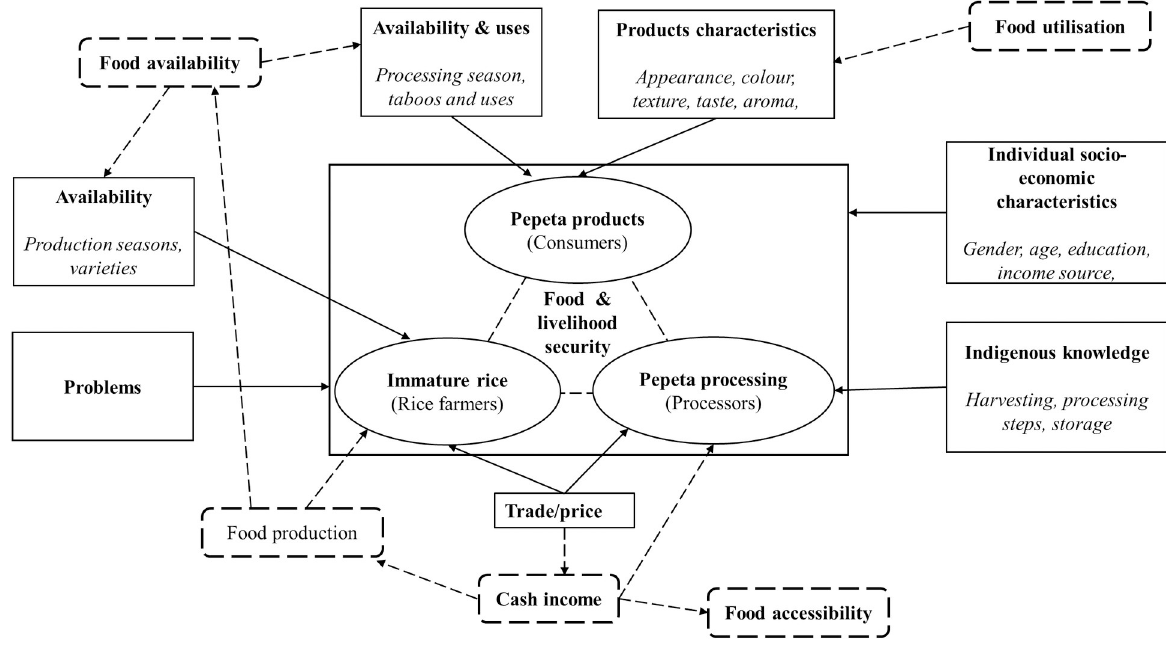
Fig 1. Conceptual framework for the design of the questionnaire used to collect information along pepeta value chain. _______ indicates possible factors that can affect pepeta value chain, and _ _ _ _ indicate elements of pepeta processing interact with food and livelihood security.